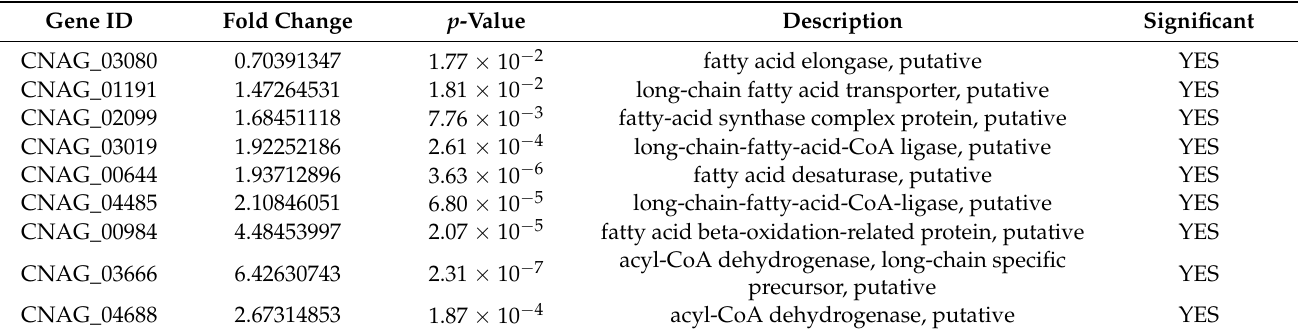
Table 2. Expression of genes encoding fatty acid oxidation proteins under low glucose compared to normal glucose. Gene